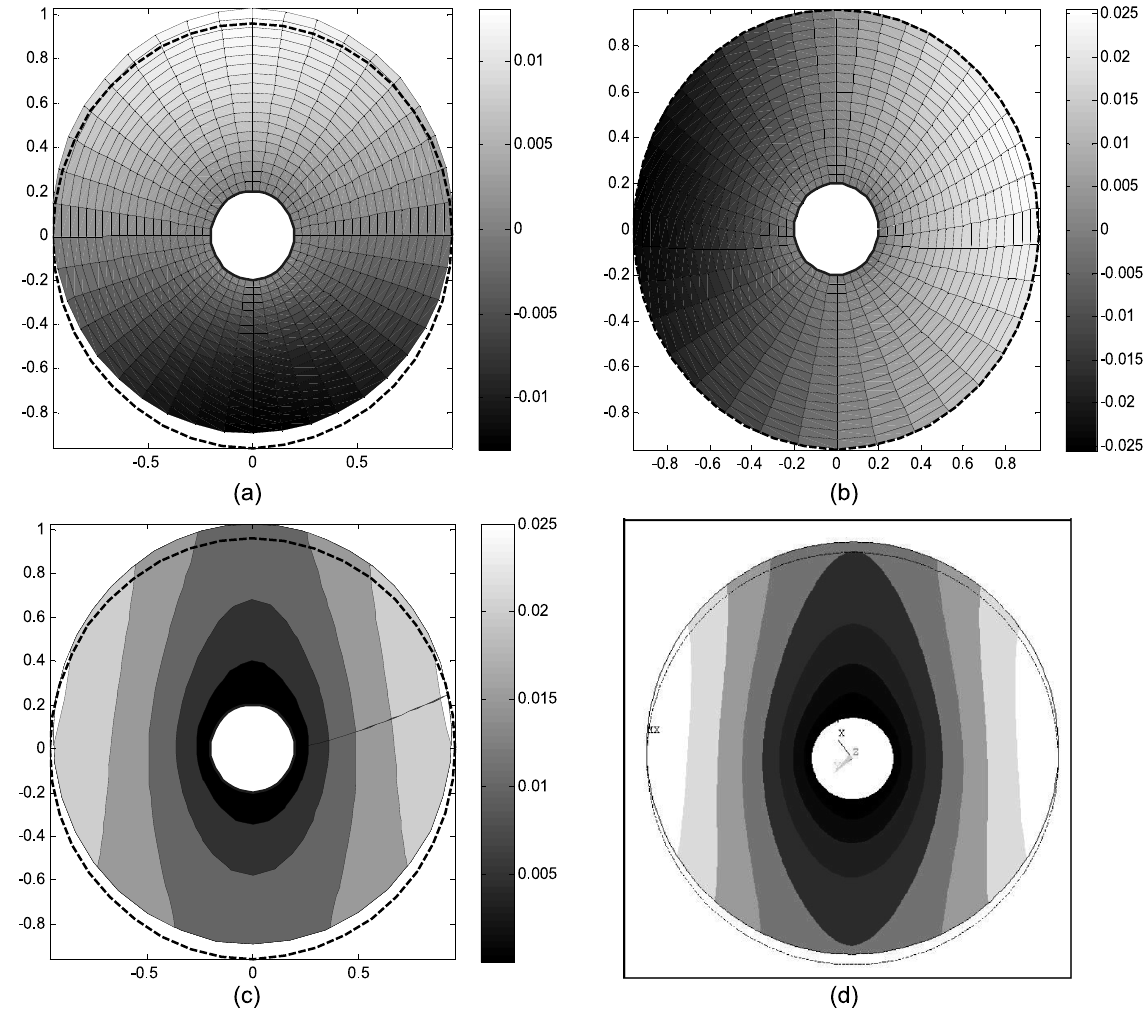
Fig. 7. Contour deformation plots for mode (0,1) for a ’Clamped-Free’ disk: a) radial displacement; b) circumferential displacement, c) vector sum of displacements; d) deformed shape from Finite element model. is purely circumferential obtained from the odd subsystem. The effect of additional point clamped support at the outer edge on this mode is illustrated Fig. 6. The fi gure illustrates the mode shapes with predominant radial and circumferential deformation, as shown in Fig. 6(a) and 6(b), respectively, that are obtained through solution of the odd subsystem. The fi gure also shows the resultant deformation mode obtained from vector summation of the radial and circumferential displacements together with the deformed shape obtained from fi nite element analysis, as seen in Fig. 6(c) and 6(d), respectively. The results show that the addition of the point clamped support yields radial displacement apart from the circumferential deformation which makes the mode neither purely circumferential nor axisymmetric. The results also show that the resultant deformation contours corresponding to mode (0,0) are quite comparable with those obtained from the fi nite element